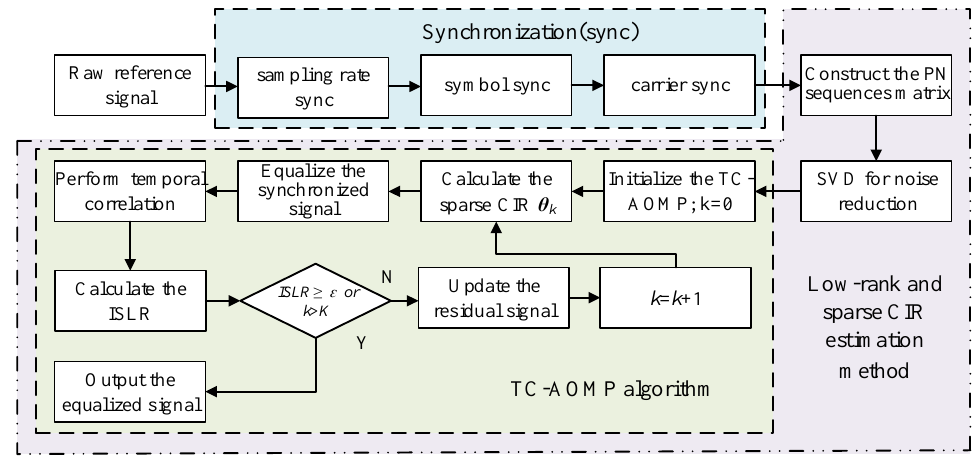
Figure 5. Flow chart of the proposed method.